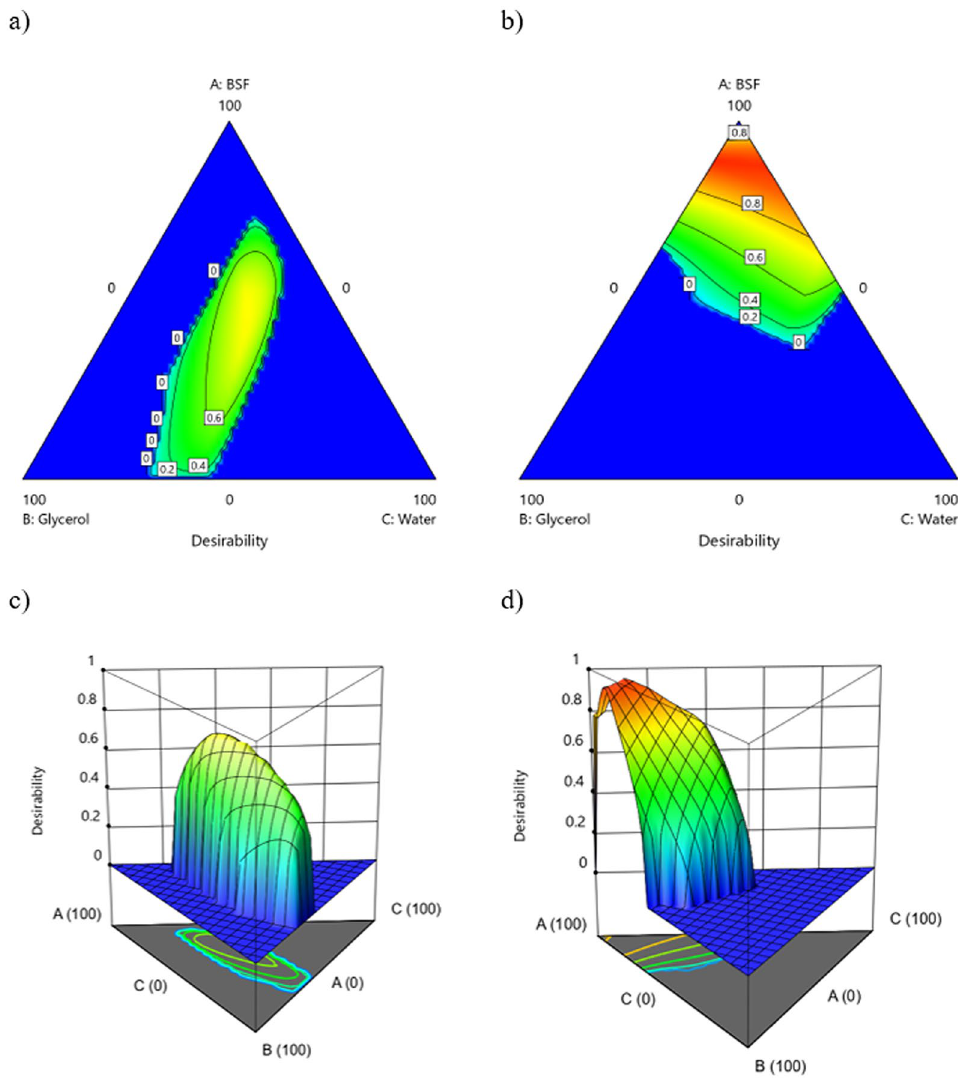
Figure 9. Contour plot for the Desirability function ( a ) S1-2D; ( b ) S2-2D; ( c ) S1-3D; ( d ) S2-3D.